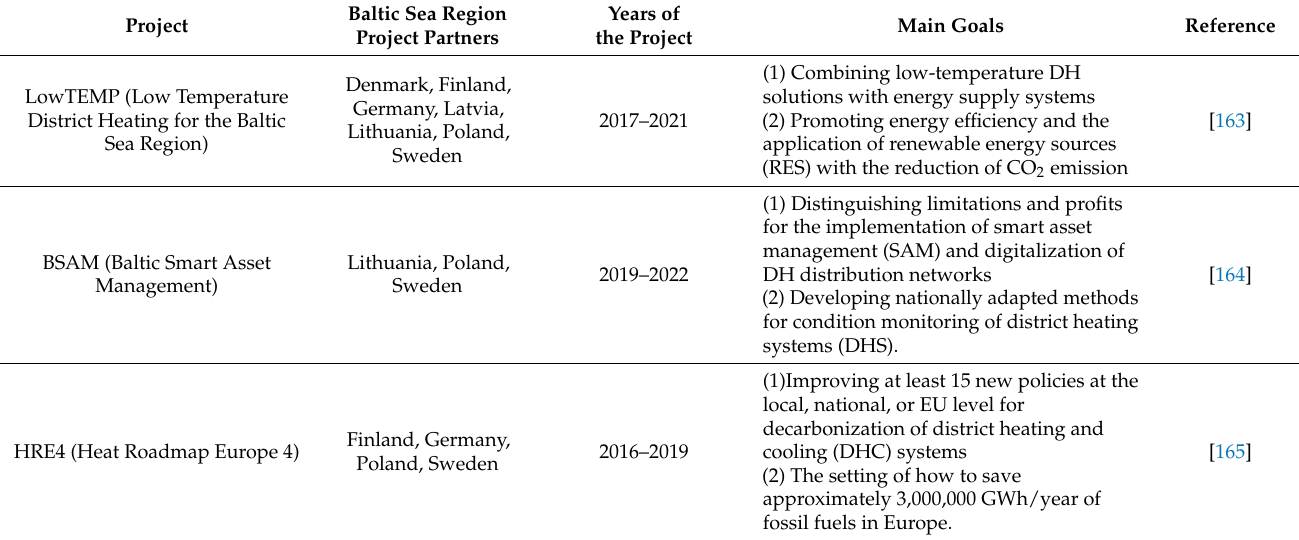
Table 2. Summary of district heating (DH) projects ongoing from 2016 with participating countries from the Baltic Sea